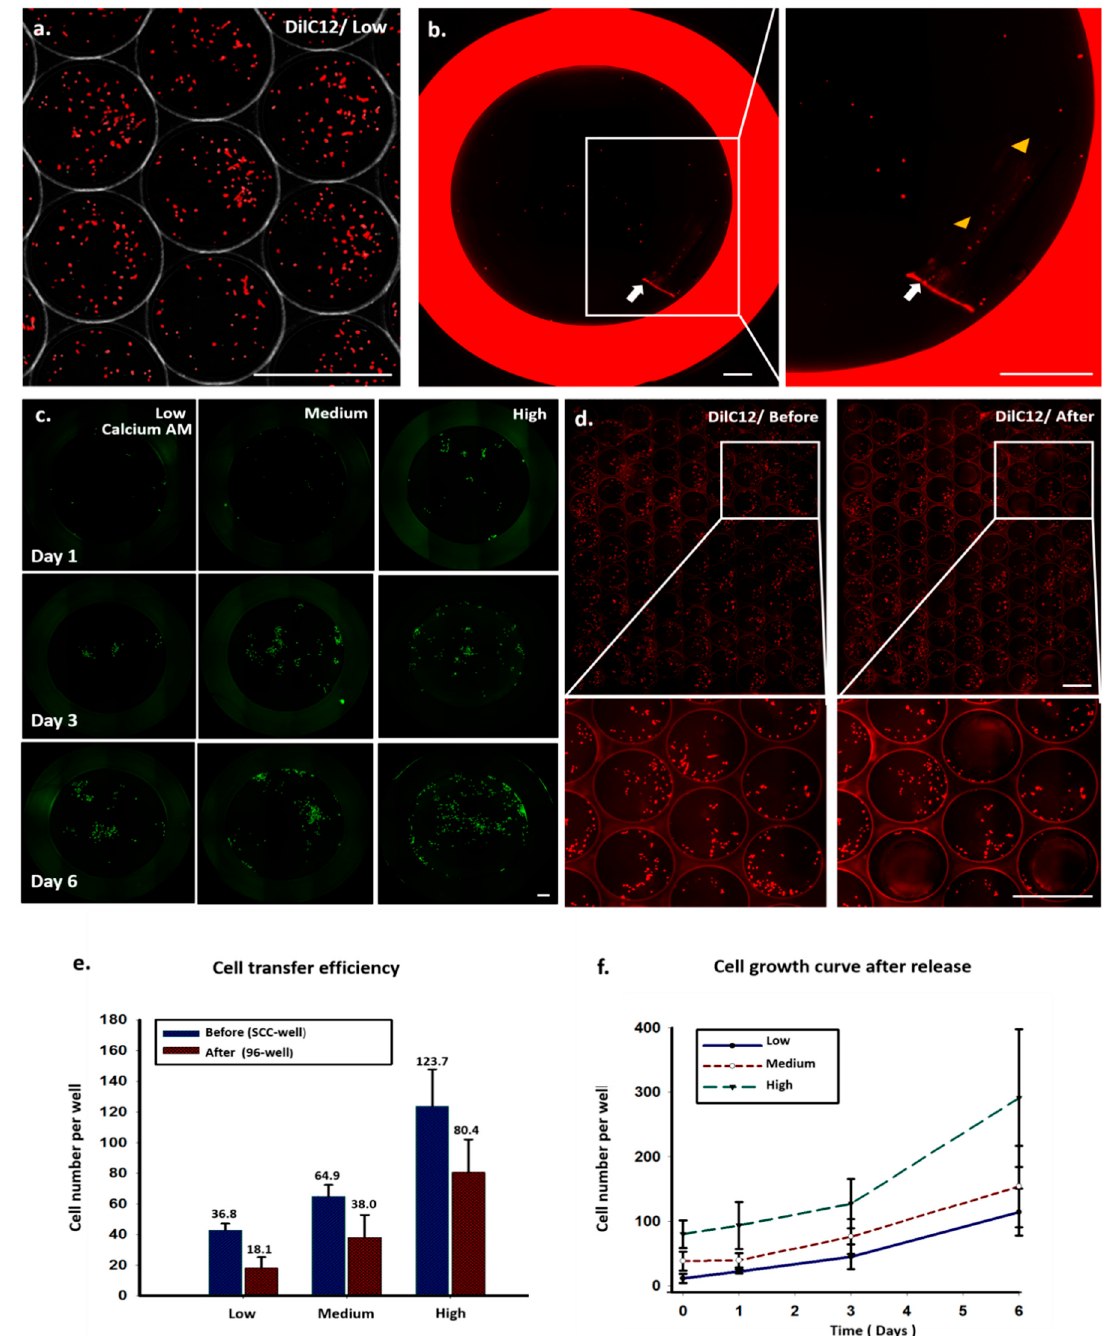
Figure 4. Quantitative analysis of cell transfer efficiency and cell growth curve by scanned images. ( a ) A549 cells were pre-stained with DilC12 dye and cultured in an SCC device for 24 h. ( b ) Image of a 96-well plate after transferring the PDMS plug (white arrow) from the SCC device. Arrowheads indicate cells being released from the PDMS plug after constant shaking. ( c ) Time-course images of cell growth of released cells from day 1 to 6. ( d ) Images of SCC device before and after punching out the wells. Enlarged images show the cells’ distribution, and localization in neighboring wells did not change after punching. ( e ) Cell transfer efficiency and ( f ) cell growth curve after release at different initial cell seeding densities.